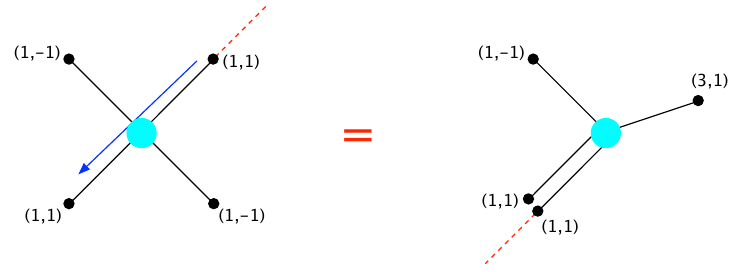
Figure 17 . Equivalent 5-brane junctions for the rank 1 E 1